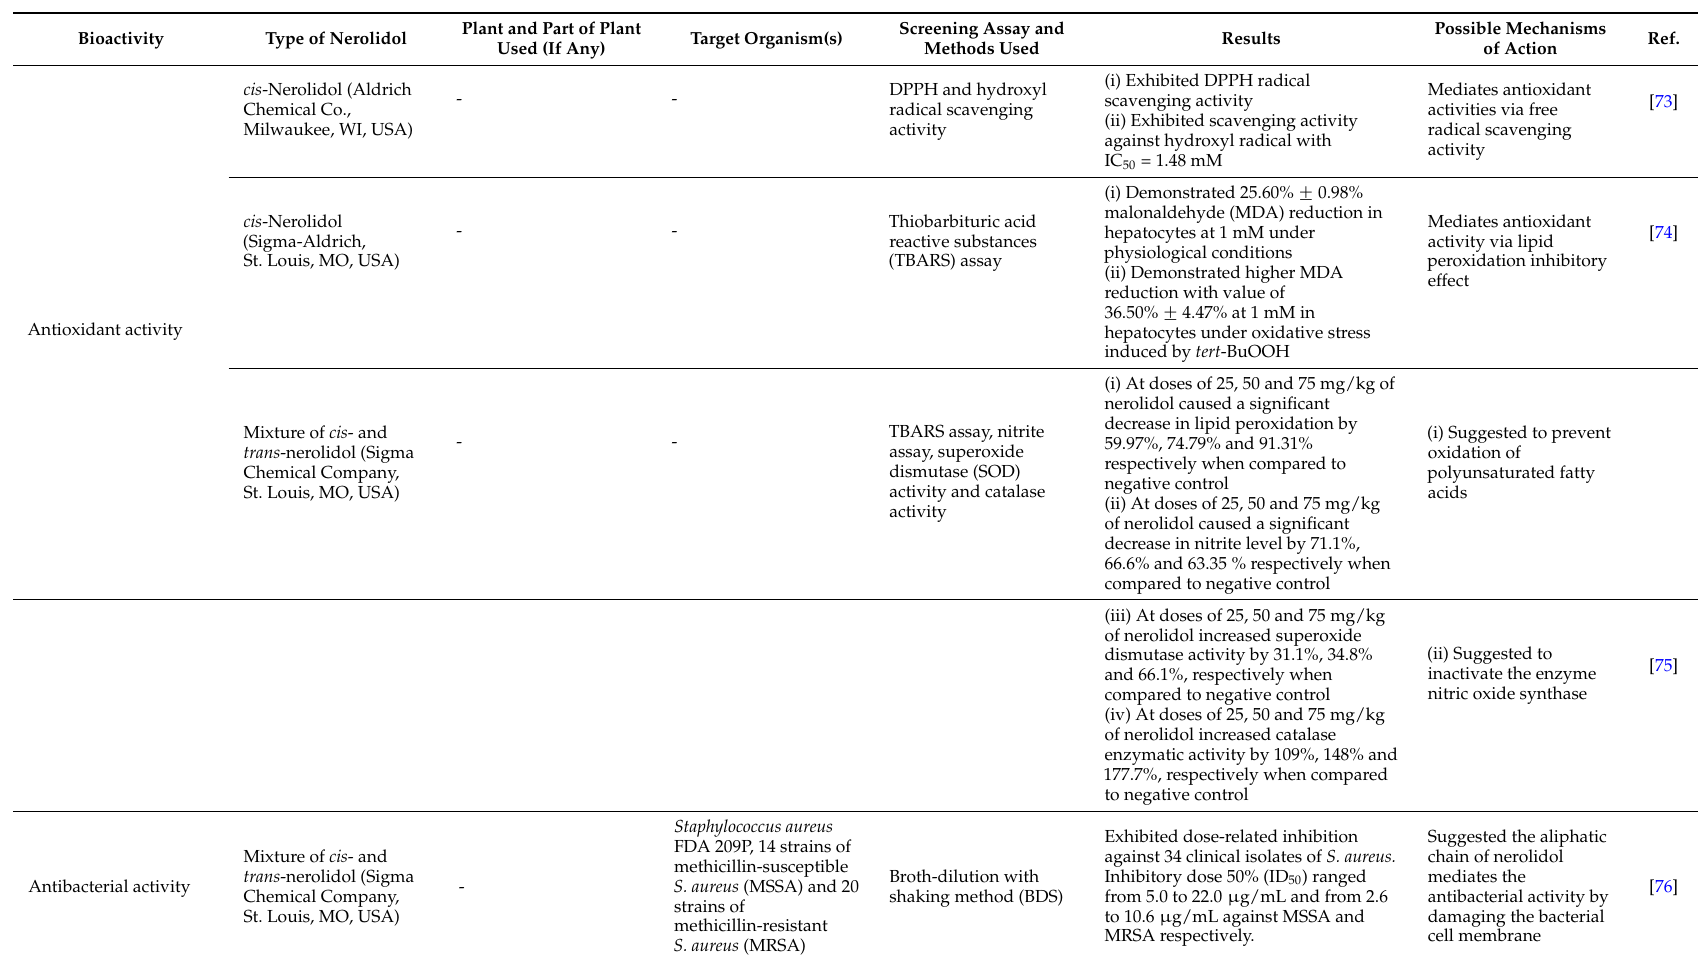
Table 4. A summary of pharmacological and biological activities of